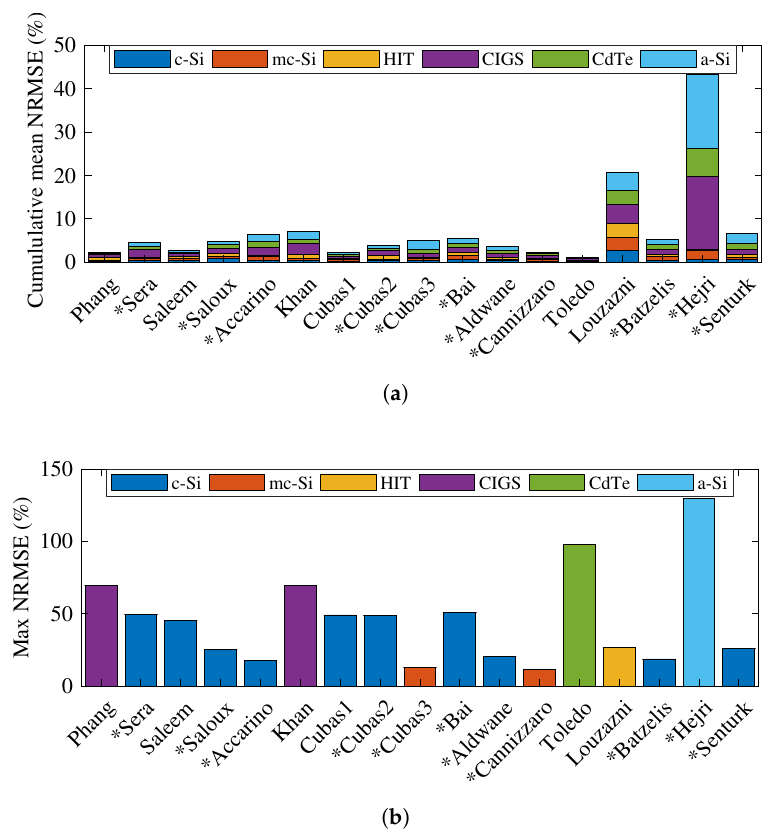
Figure 4. Accuracy of the 17 methods. ( a ) Cumulative mean normalized RMSE and ( b ) max normalized RMSE for the various PV technologies.